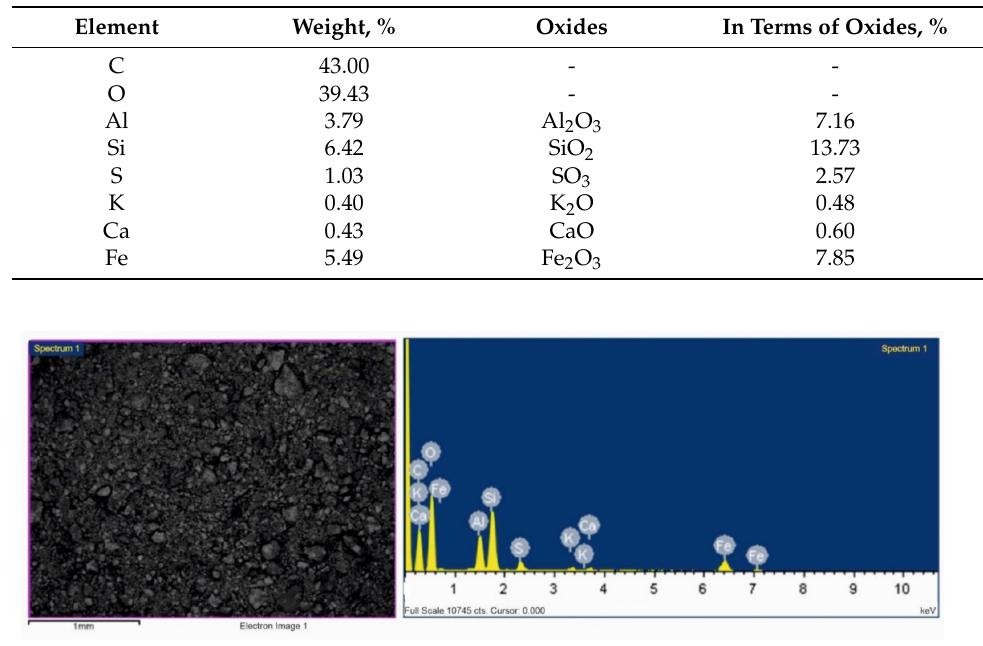
Table 2. Element-weight composition of coal mining waste.